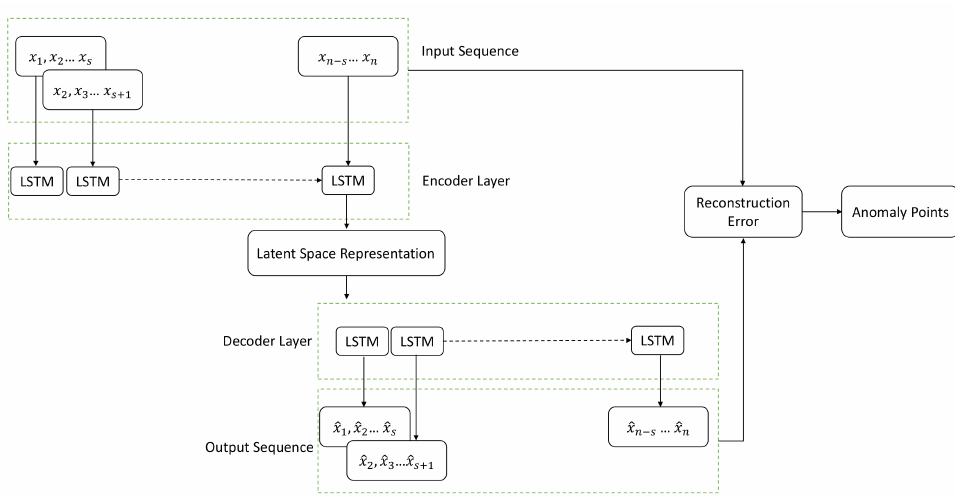
Figure 9. Anomaly detection method based on reconstruction errors